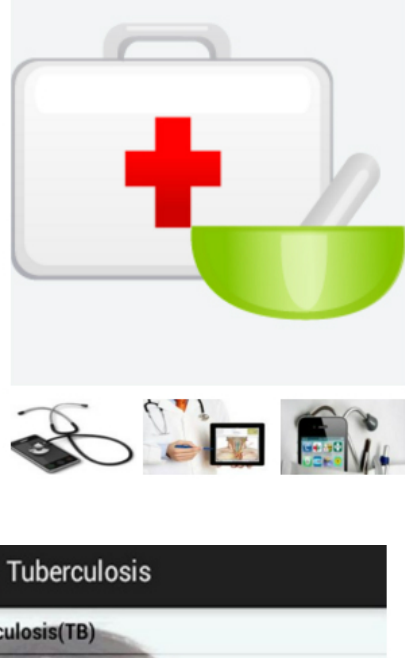
Figure 4. Tuberculosis Symptoms Guide.